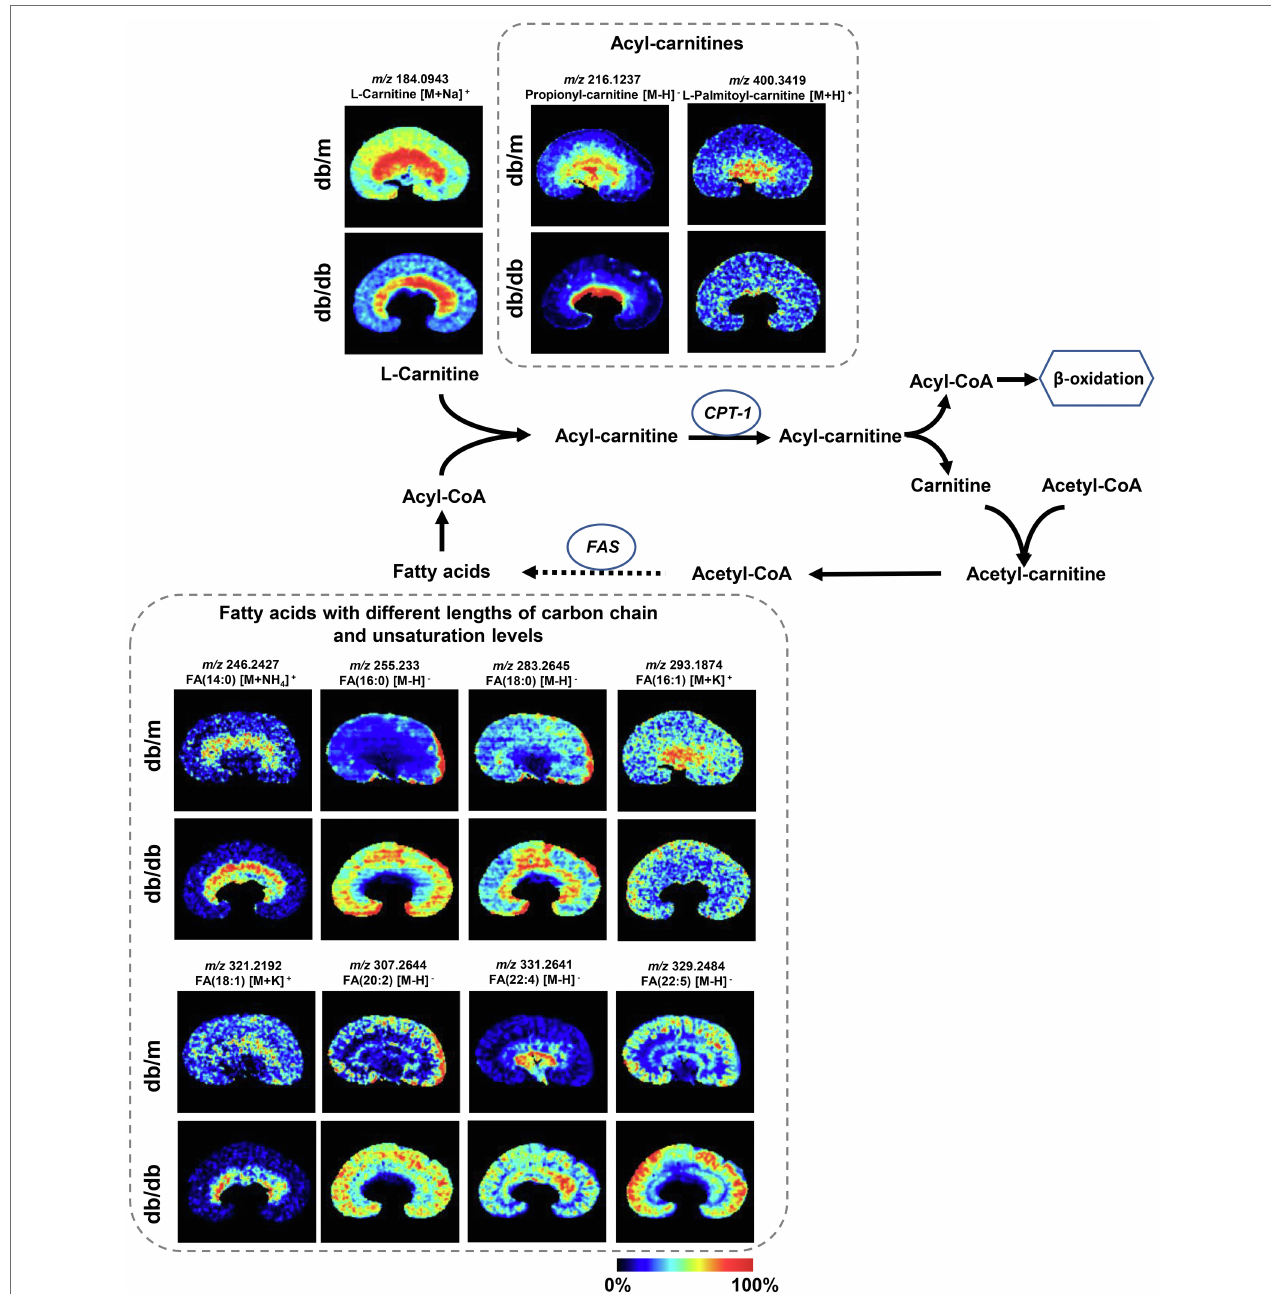
FIGURE 5 | Mass spectrometry images of discriminating metabolites involved in the disturbance of fatty acid degradation pathway and biosynthesis of fatty acids pathway. The blue ellipses represent rate-limiting enzymes that regulate certain metabolic pathways. FA, fatty acid; CPT1, carnitine O-palmitoyl-transferase 1; and FAS, fatty acid